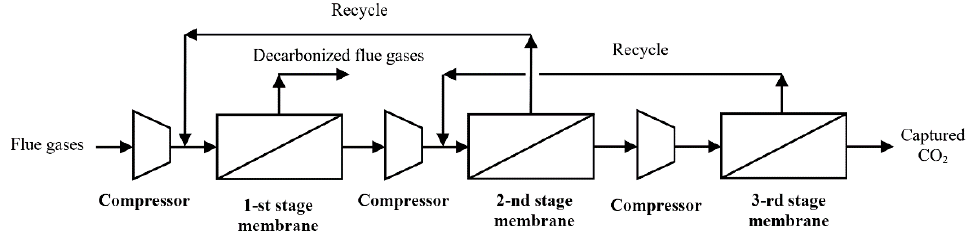
Figure 2. CO 2 capture plant by three-stage membrane unit (benchmark).